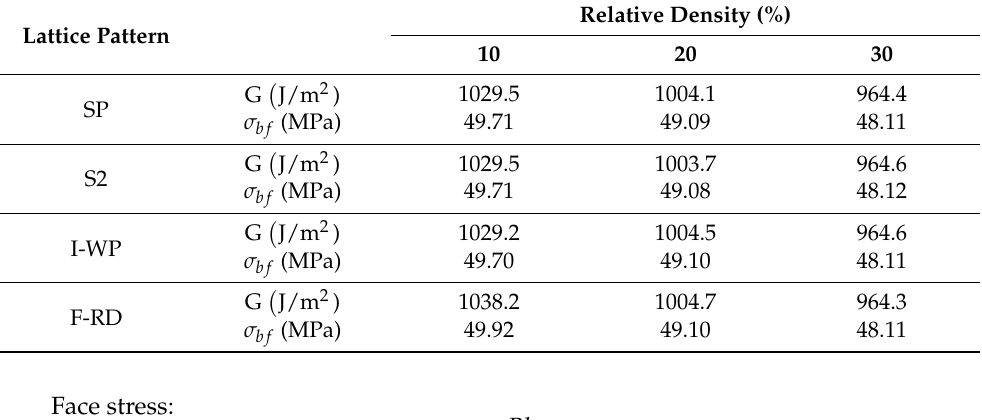
Table 12. Maximum bond